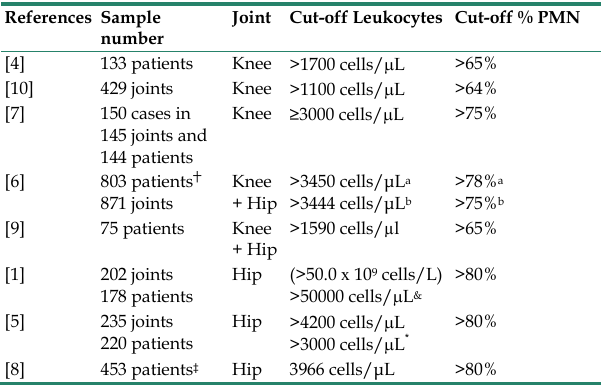
Table 2. Selected publications revealing cut-off values for synovial cell count and differential in patients with periprosthetic hip and knee joint infections.